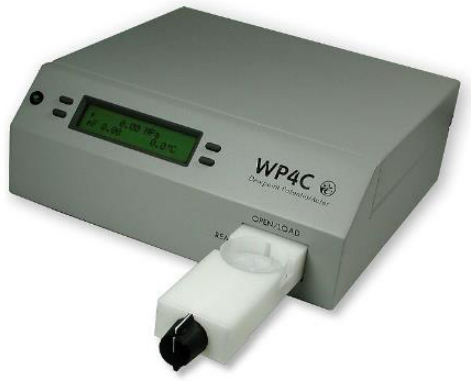
Figure 5. WP4C dewpoint potential meter.